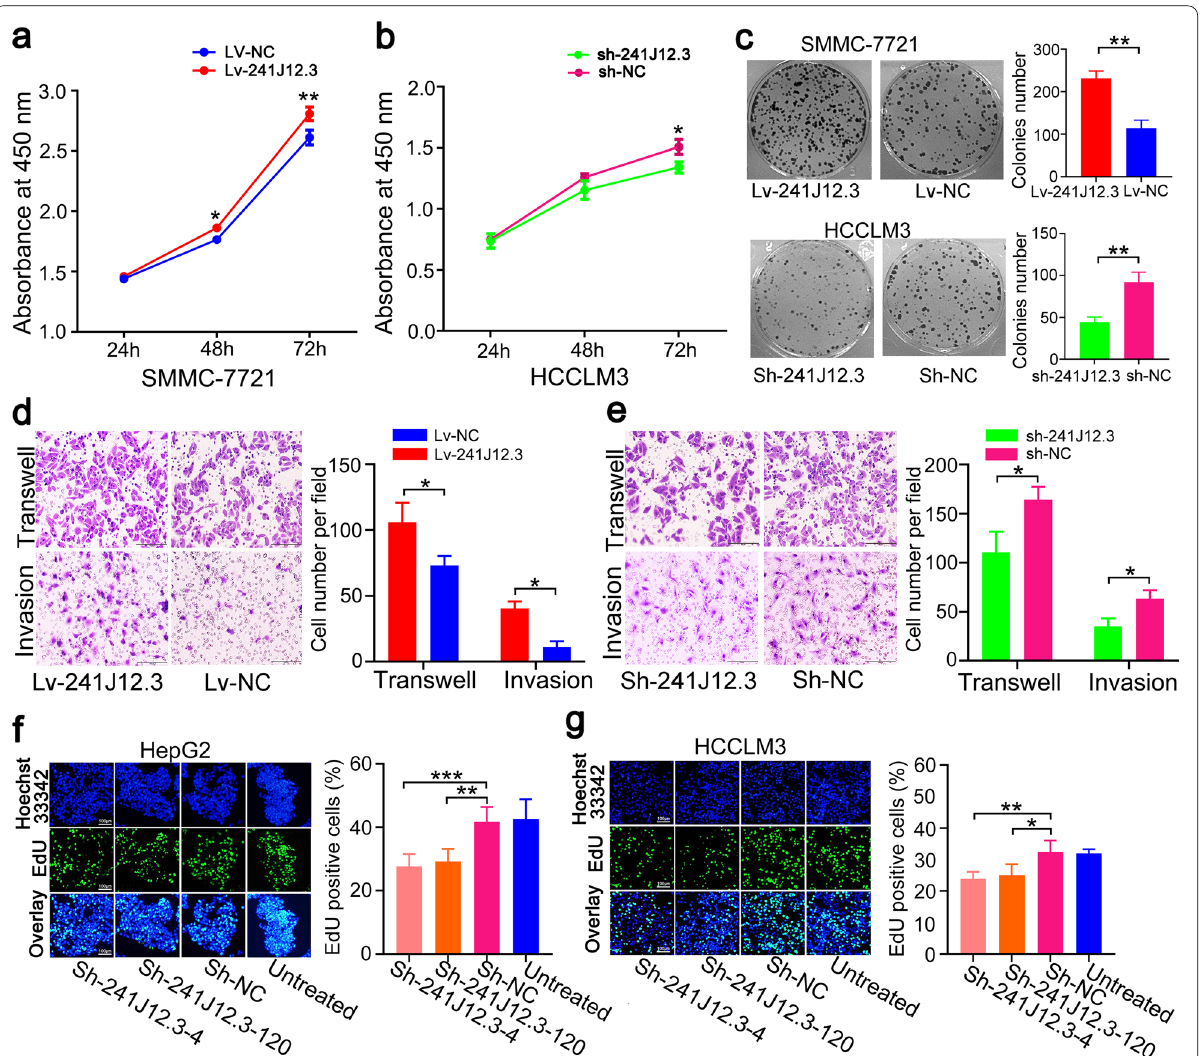
Fig. 3 Upregulation of RP11-241J12.3 stimulated HCC cells colony-formation migration and invasion, and accelerated DNA synthesis. a Cell colony formation assays showing that RP11-241J12.3 overexpression increased SMMC-7721 cell colonies; the opposite was observed after RP11-241J12.3 knockdown. Specific analysis is shown on the right. b‑c After separate overexpression of RP11-241J12.3 in SMMC-7721 cells or silencing it in HCCLM3 cells, the cell viability was assessed by cell proliferation assay. d‑e After separate overexpression or silencing of RP11-241J12.3, migration of SMMC-7721 cells was evaluated in Transwell assays. Quantification of the cells is shown on the right. f‑g HepG2 and HCCLM3 cells transfected with ShRNAs (Sh-241J12.3-4 or 120, Sh-NC, untreated) were seeded on 96-well plates and the effect of RP11-241J12.3 knockdown on cell proliferation was evaluated using EdU incorporation assay at 72 h post-transfection. Quantification of EdU-positive nuclei is shown on the right. Data